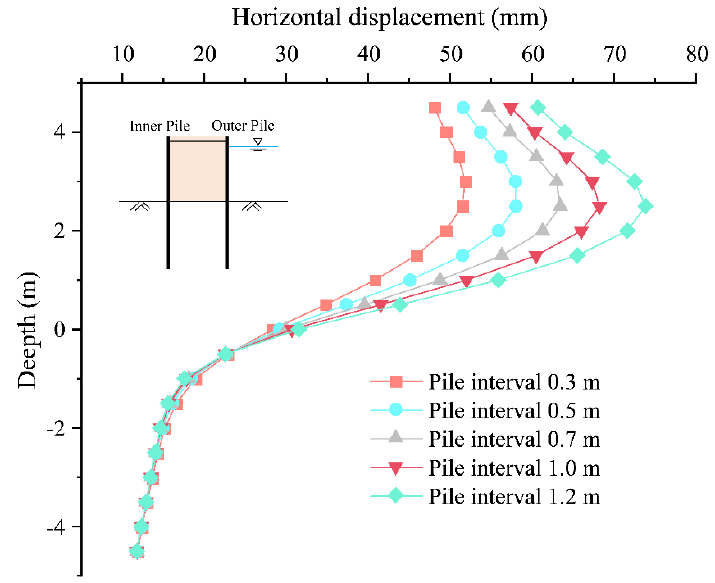
Figure 21. Pile horizontal displacement of wood pile interval conditions.